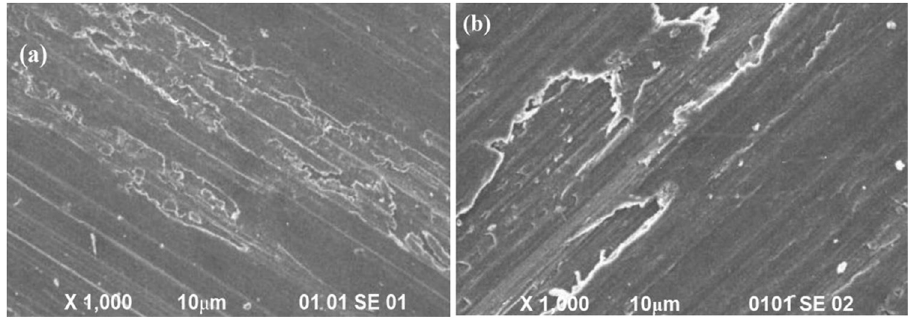
Figure 5: Wear morphology of samples ( a ) AH 1 and ( b ) AH 12 .